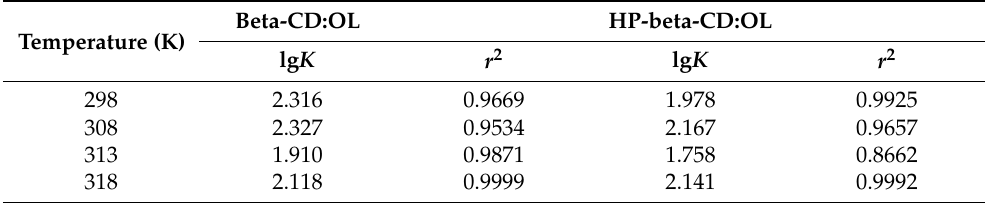
Table 1. The calculated stability constants of beta-CD:OL and HP-beta-CD:OL under different temperatures. Temperature (K)